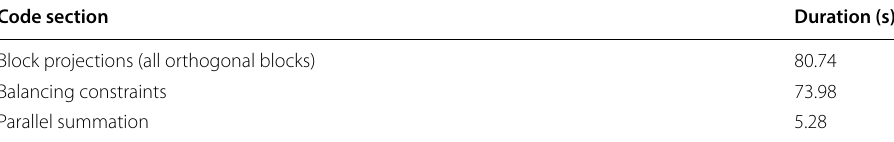
Table 1 Runtime results of the ACIM code for the Eora model Code